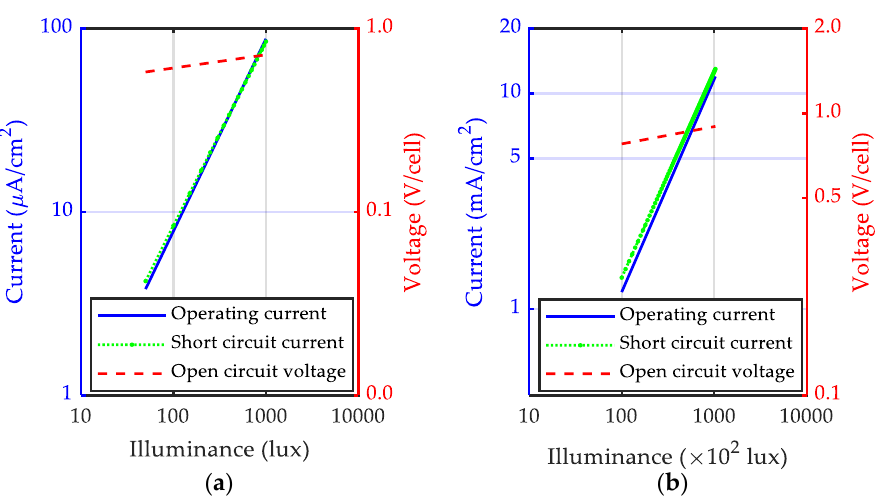
Figure 6. Relationship between the solar cell outputs and illuminance: ( a ) Indoor illumination; ( b ) Outdoor illumination.